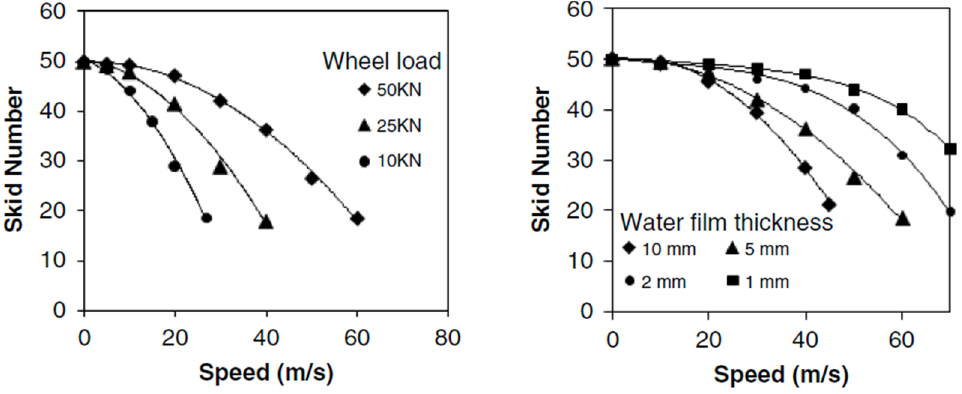
Figure 3. Dynamic skid number versus aircraft speed for various WFTs and wheel loads [9].